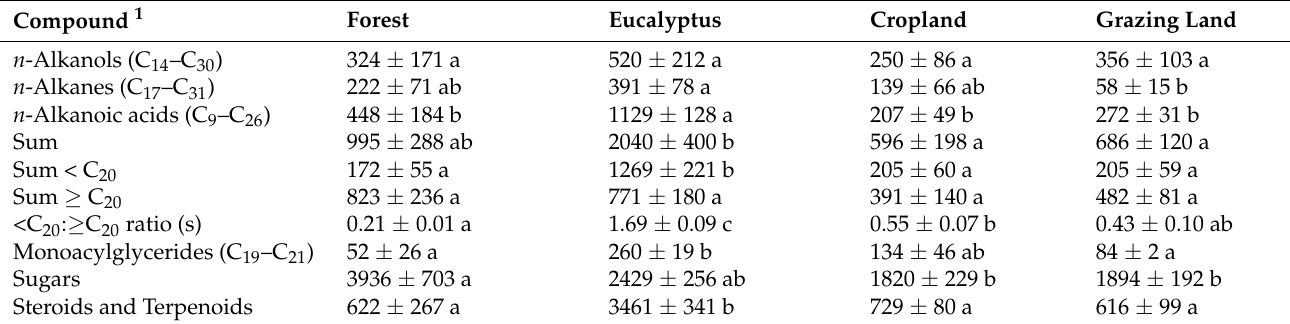
Table 2. Compounds, their sums, and their ratios, as identified in the solvent (s) extracts of soil samples of different land-use systems in Gelawdios, Ethiopia (mean ± SE, n = 3). All values are in ( µ g g − 1 C). Different letters indicate a significant difference between land-uses ( p ≤